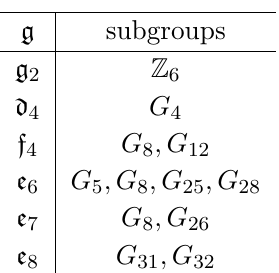
Table 2 . The subgroups of Weyl groups of g which appear in our analysis. The non-simply-laced cases will be discussed in section